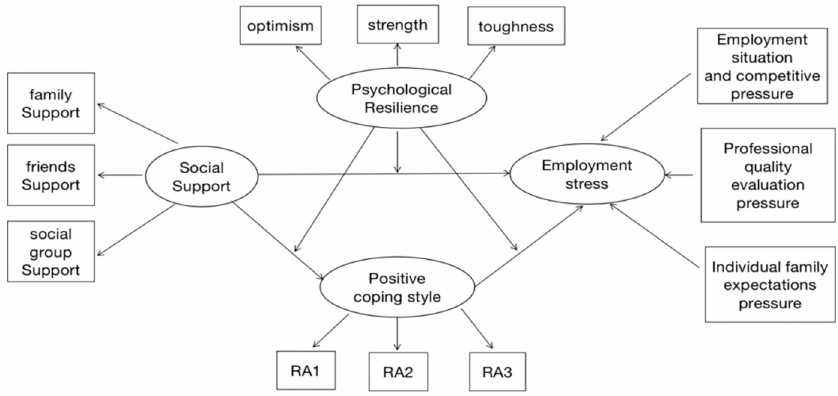
Figure 1. Conceptual